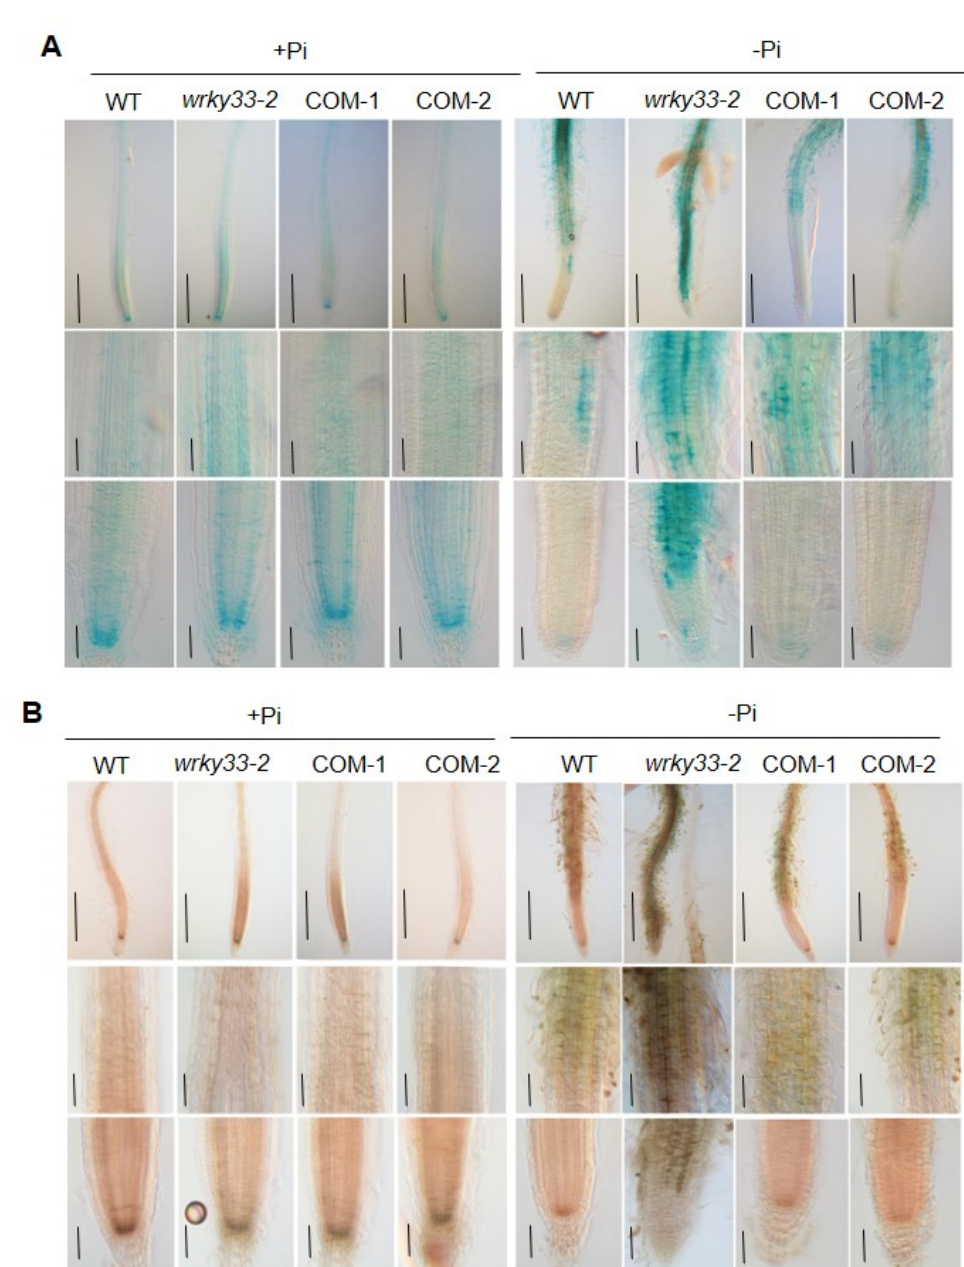
Figure 3. WRKY33 regulates the Fe accumulation under Pi deficiency. ( A ) Fe staining by the Perls method. ( B ) Fe staining by the Perls/DAB method. Four-day-old seedings of WT, wrky33-2 , COM-1, and COM-2 seedlings were grown on Pi-sufficient (+Pi) or Pi-insufficient ( − Pi) for three days; the roots were stained to observe the Fe accumulation. The top, middle, and bottom rows in each section are photographs of the whole root, higher magnification of the maturation zone and the transition zone, and higher magnification of the apical region, including the root cap and meristem, respectively. The experiments were repeated three times with similar results. Bar = 50 um.